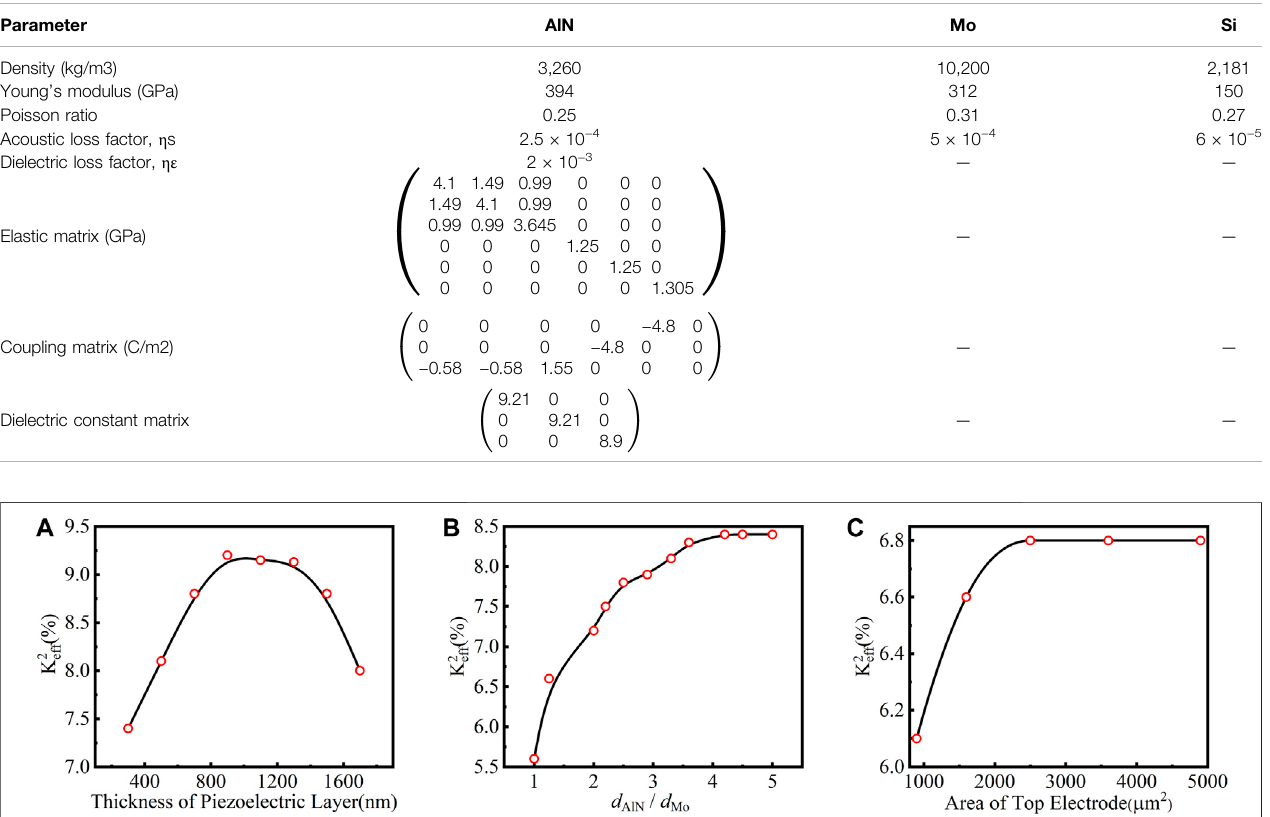
FIGURE2|(A) K 2 eff ofFBARwithvaryingthicknessesofthepiezoelectriclayer; (B) K 2 eff ofFBARwithvaryingthicknessratiosofthepiezoelectrictoelectrodelayers; (C) K 2 eff of FBAR with varying areas of the top electrode.